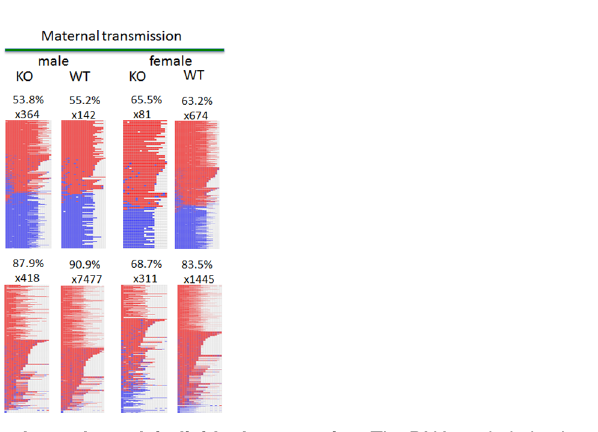
Fig 7. DNA methylation level analyses through individual sequencing. The DNA methylation levels of the Peg3-DMR and Zfp264 promoter were also analyzed using an NGS-based bisulfite sequencing protocol. This methylation survey used the exact same sets of PCR products that had been used for COBRA in Fig 5B . Thus, the results of these analyses were presented in a similar format. The two sets of 8 PCR products representing the Peg3-DMR (upper) and Zfp264 promoter (bottom) were derived from the mice with both genders that inherited the knockin allele paternally and maternally. The numbers of raw sequence reads used for calculating the overall DNA methylation level for a given locus are shown above each image. The image composed of a large number of blue and red boxes represents the graphic summary of DNA methylation patterns. Each horizontal line represents one sequence read while each small box within this line indicates one CpG dinucleotide. The blue and red boxes indicate the unmethylated and methylated CpG sites,